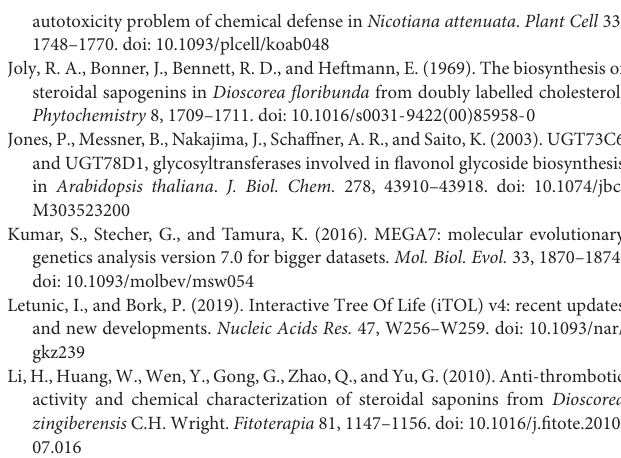
Supplementary Figure 1 | The amino acid sequence alignment of DzGT1-DzGT4. Supplementary Figure 2 | SDS-PAGE electrophoresis analysis of the purified recombinant DzGTs. Supplementary Figure 3 | Structure of the substrates used for the enzyme assays of DzGT1. Supplementary Figure 4 | Nonlinear regression analysis of DzGT1 with trillin using the GraphPad Prism 5.01 software. Supplementary Figure 5 | Bioinformatic analysis of DzGT1. Supplementary Figure 6 | The calibration curve of PSA. Supplementary Table 1 | Information of the glycosyltransferases used in the phylogenetic analysis. Supplementary Table 2 | Primers used for the gene amplifications in this